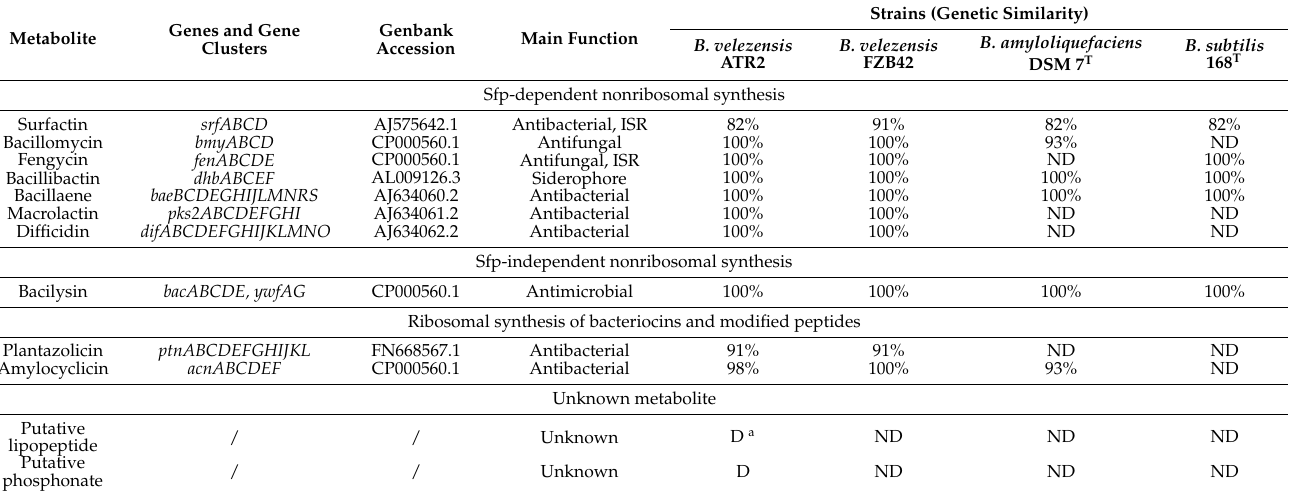
Table 2. Predicted secondary metabolite clusters in genomes of B. velezensis ATR2 and related representative Bacillus